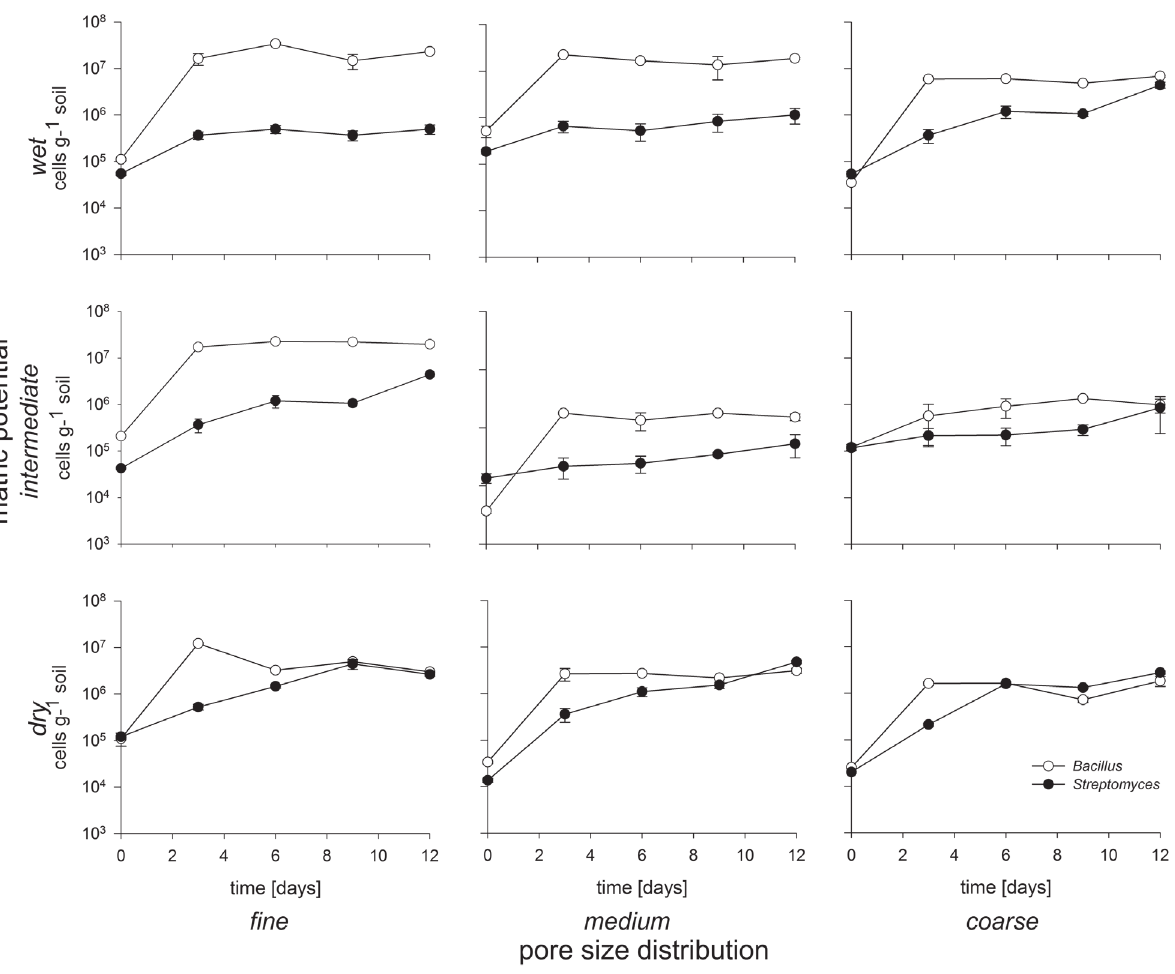
Figure 4. Population dynamics of Streptomyces and Bacillus competing in nine different combinations of pore size distribution and matric potential. The x-axis is time in days and the y-axis is cell number (g drywt soil) on a log-scale. Each data point is the mean of three microcosm replicates. Error bars show the standard deviation.